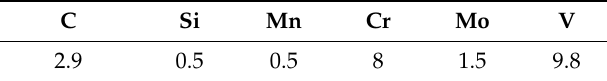
Table 1. Composition